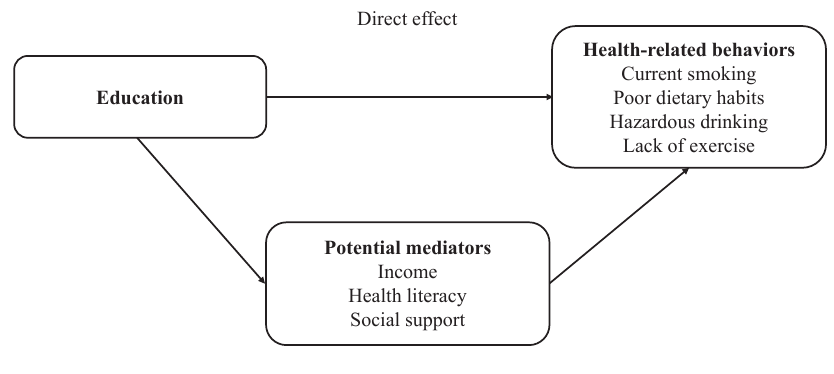
Fig. 1 Conceptual framework of the mediation